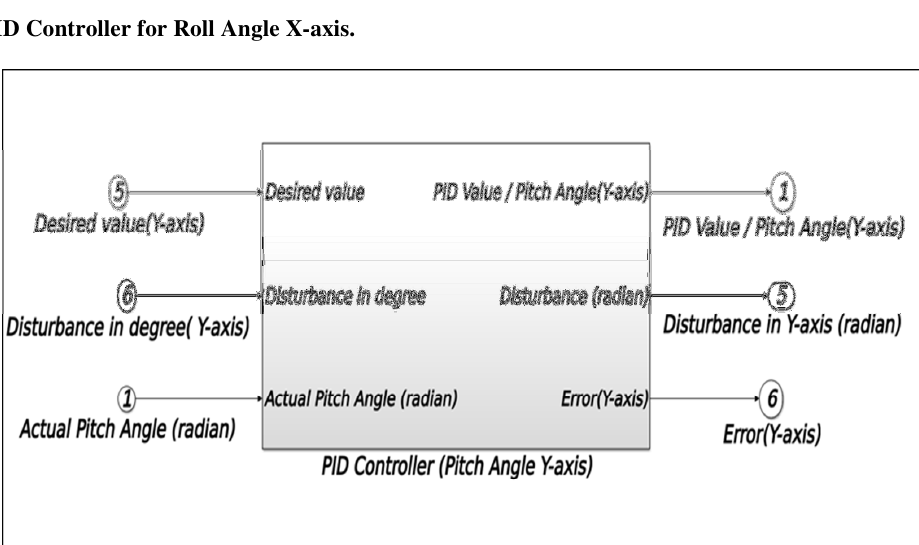
Fig. 3. PID Controller Subsystem.